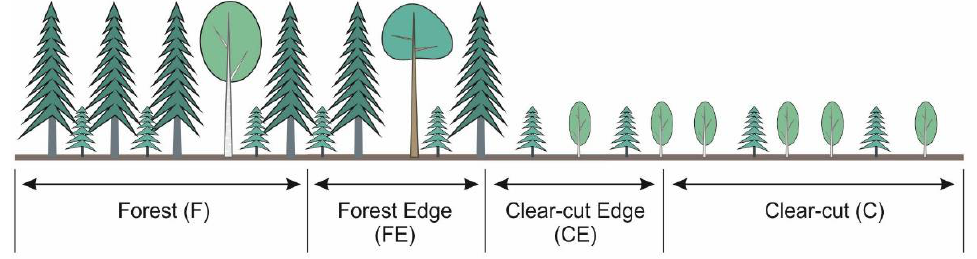
Figure 1. Arrangement of ecotone zones and their notations. See text for